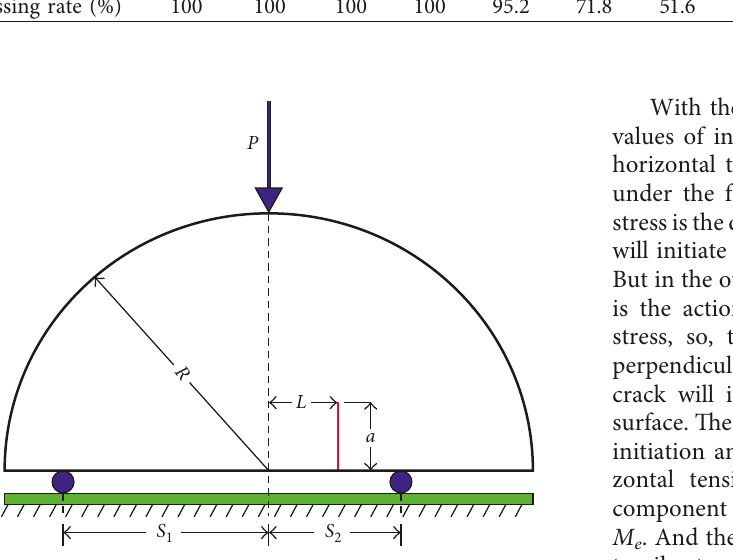
Figure 2: Positions of bearings and prefabricated crack in specimen.